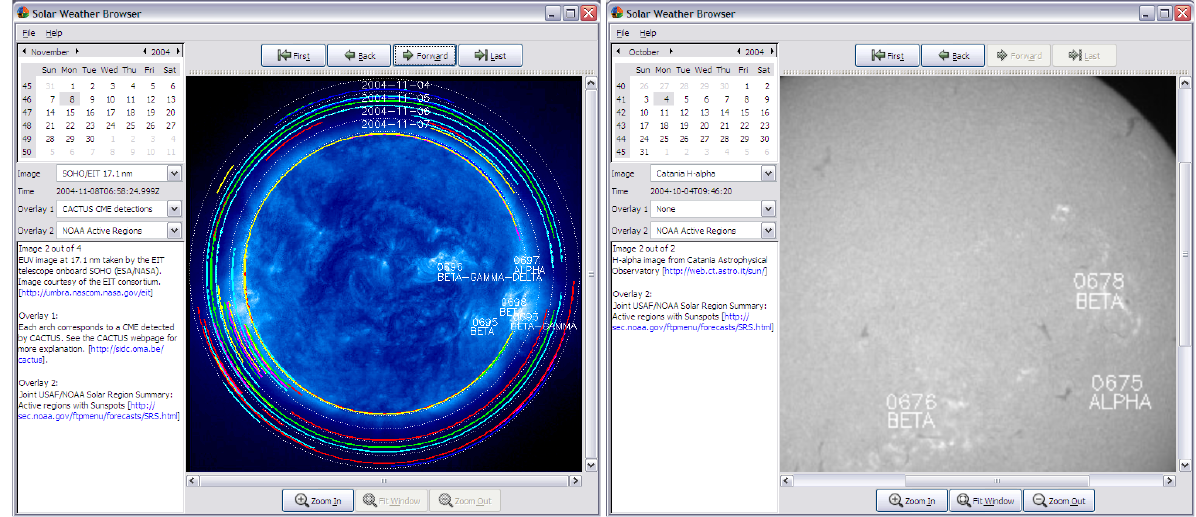
Fig. 5. Screenshots of the